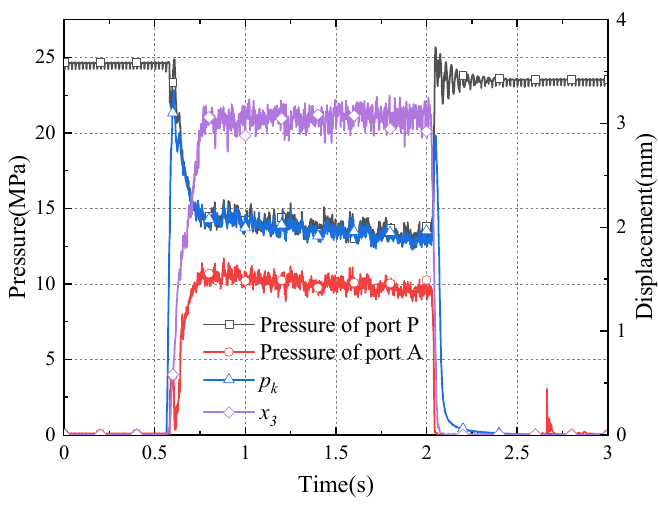
Figure 10. Pressure of the step response test under 25 MPa.